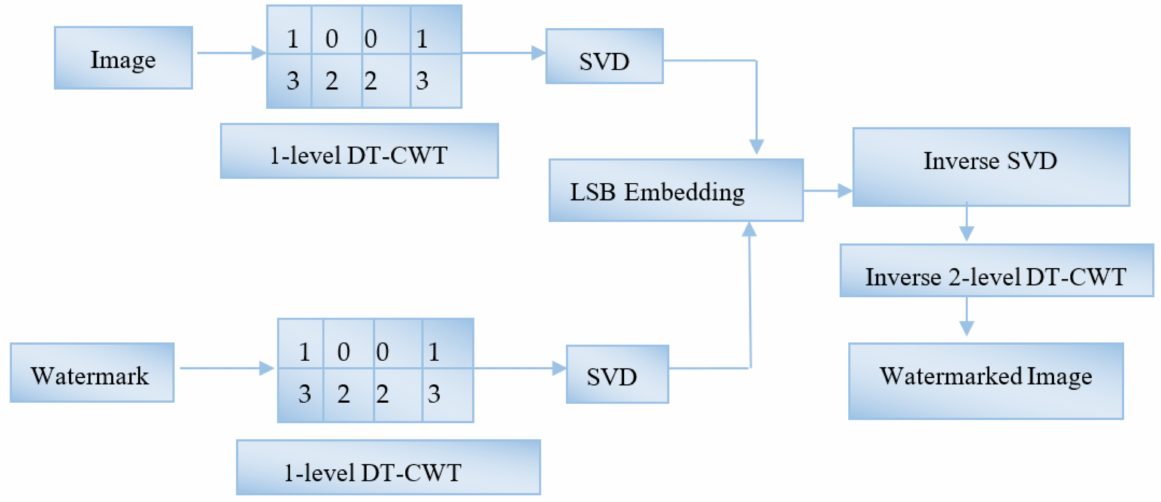
Figure 7. DT-CWT-based SVD watermark embedding procedure using the LSB method. The Watermark